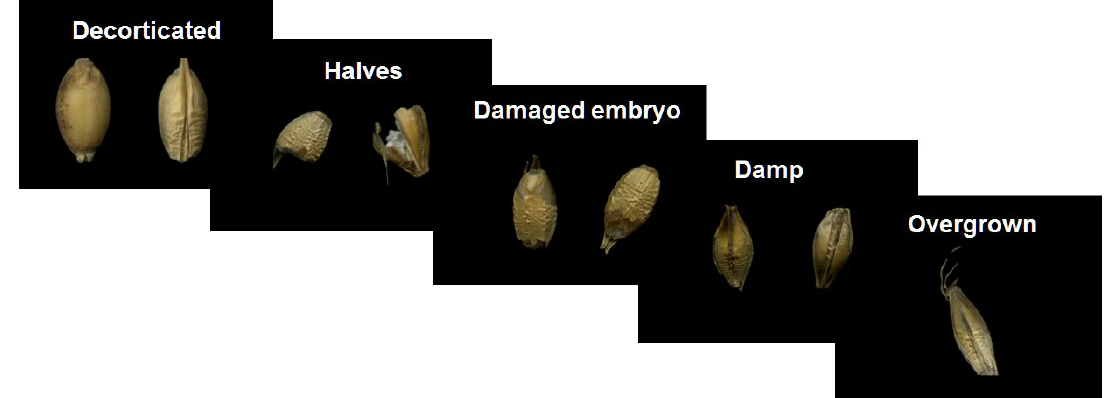
Figure 4. Exemplary images of imperfections of kernels or types of contamination. The created IT system “ Hordeum v.3.2” (Figure 3) was equipped with a module de- signed to generate graphic parameters characterizing digital images. Sixty-four standard descriptors representing kernel graphics were selected, which are further input variables of training files necessary in the process of creation of ANN models (see Figure 5).